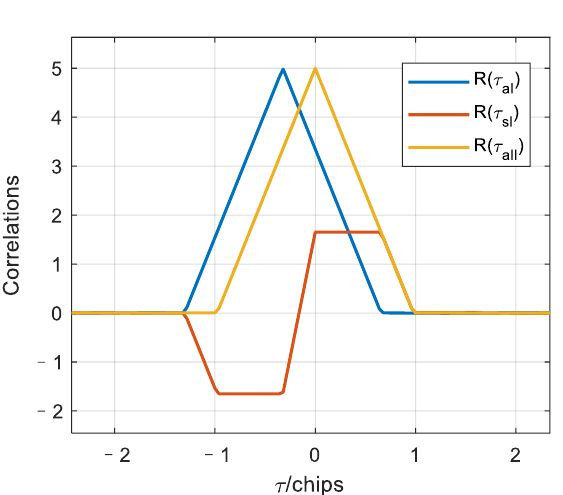
Figure 6. Diagram of correlation function of covert spoofing traction.